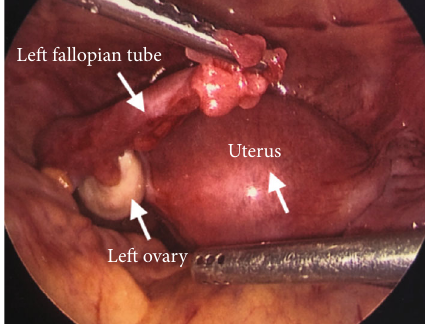
Figure 2: Laparoscopic image of unremarkable left fallopian tube and left ovary.